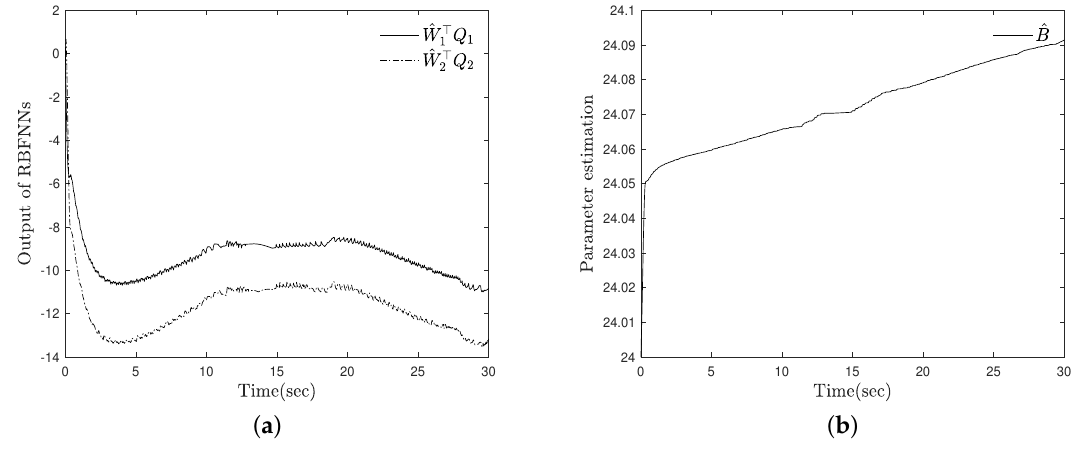
(cid:62) ˆ W (cid:62) ˆ B 1 Q 1 and 2 Q 2 ( b )